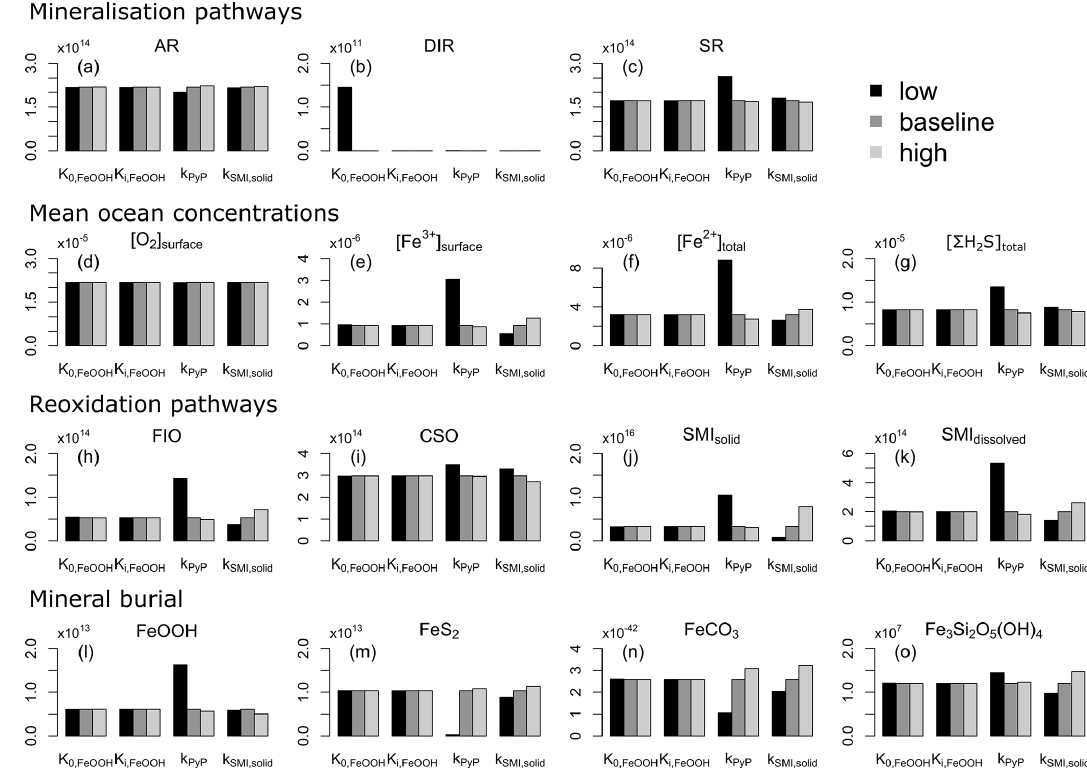
Figure 12. Global model output for the three different values of the four key parameters ( K 0 , FeOOH , K i , FeOOH , k PyP , and k SMI , s ). Low, baseline, and high values are given in Table 7. Panels (a) – (c) and (h) – (n) are in moles per year (molyr − 1 ), and panels (d) – (g) are in moles per kilogramme (molkg − 1